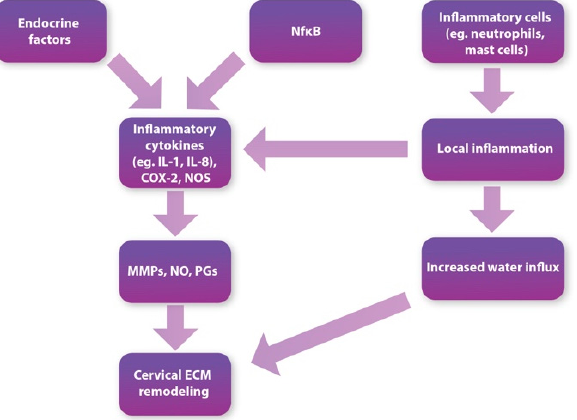
Figure 1. Diagram showing an outline of the changes occurring during cervical ripening.